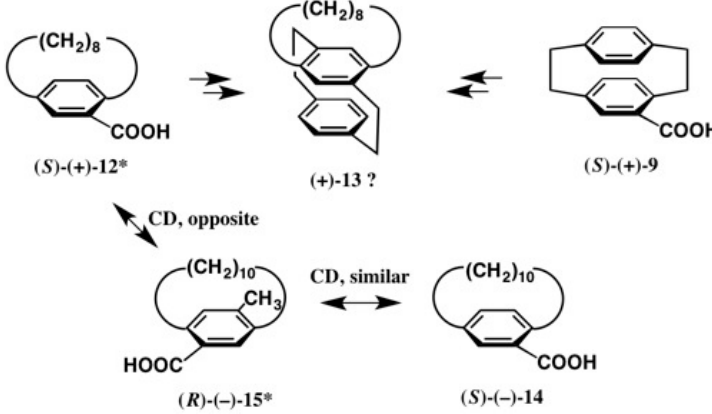
Figure 11. Absolute configurations (ACs) of chiral paracyclophane-carboxylic acids assigned by chemical correlation and comparison of circular dichroism (CD) spectra, where the ACs designated with an asterisk * were reversed, as will be explained below. The AC of compound (+)- 13 has remained unclear. Redrawn with permission from [30].